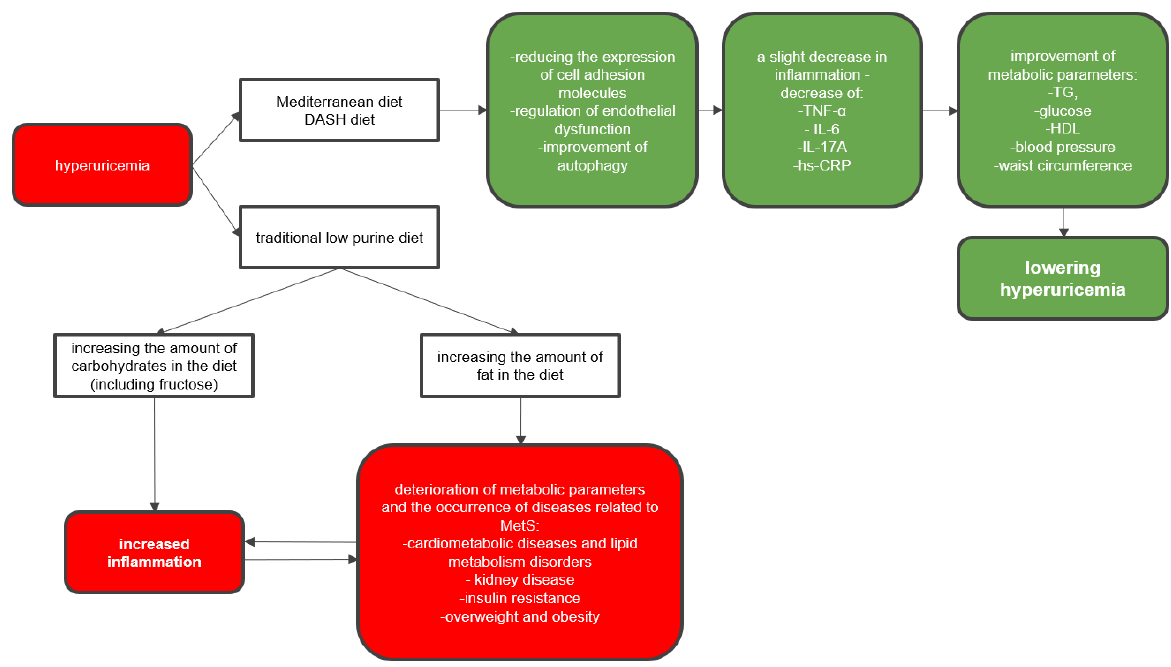
Figure 4. Consequences of improper dietary interventions in patients with hyperuricemia and MetS-related diseases. Following a low-purine diet leads to supplementation of calories with carbohydrates and fats, which may exacerbate MetS-related conditions. The use of an otherwise balanced diet (Mediterranean, DASH) may alleviate the symptoms of MetS and reduce hyperuricemia. Ab-